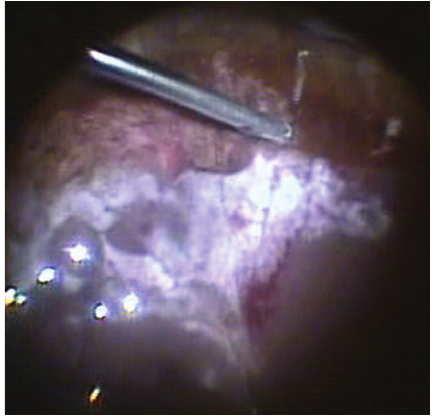
Figure 3: Picture taken during surgery showing signs of active retinitis.